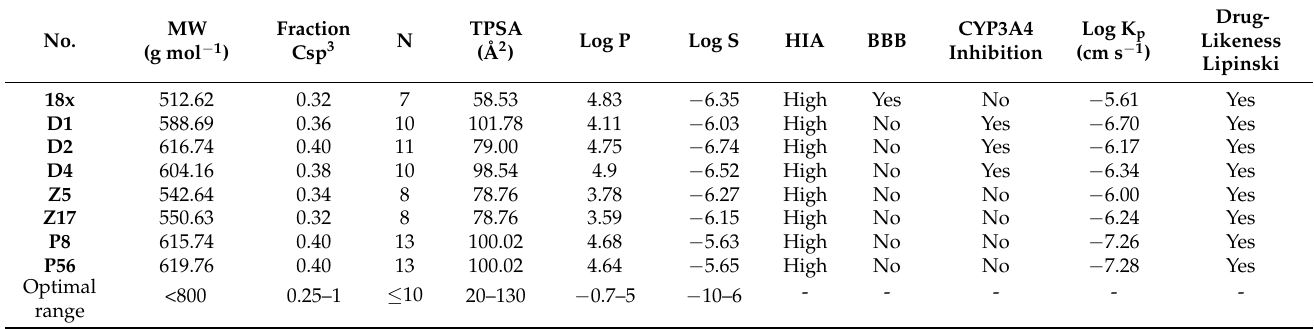
Table 7. Bioavailability and pharmacokinetics prediction.